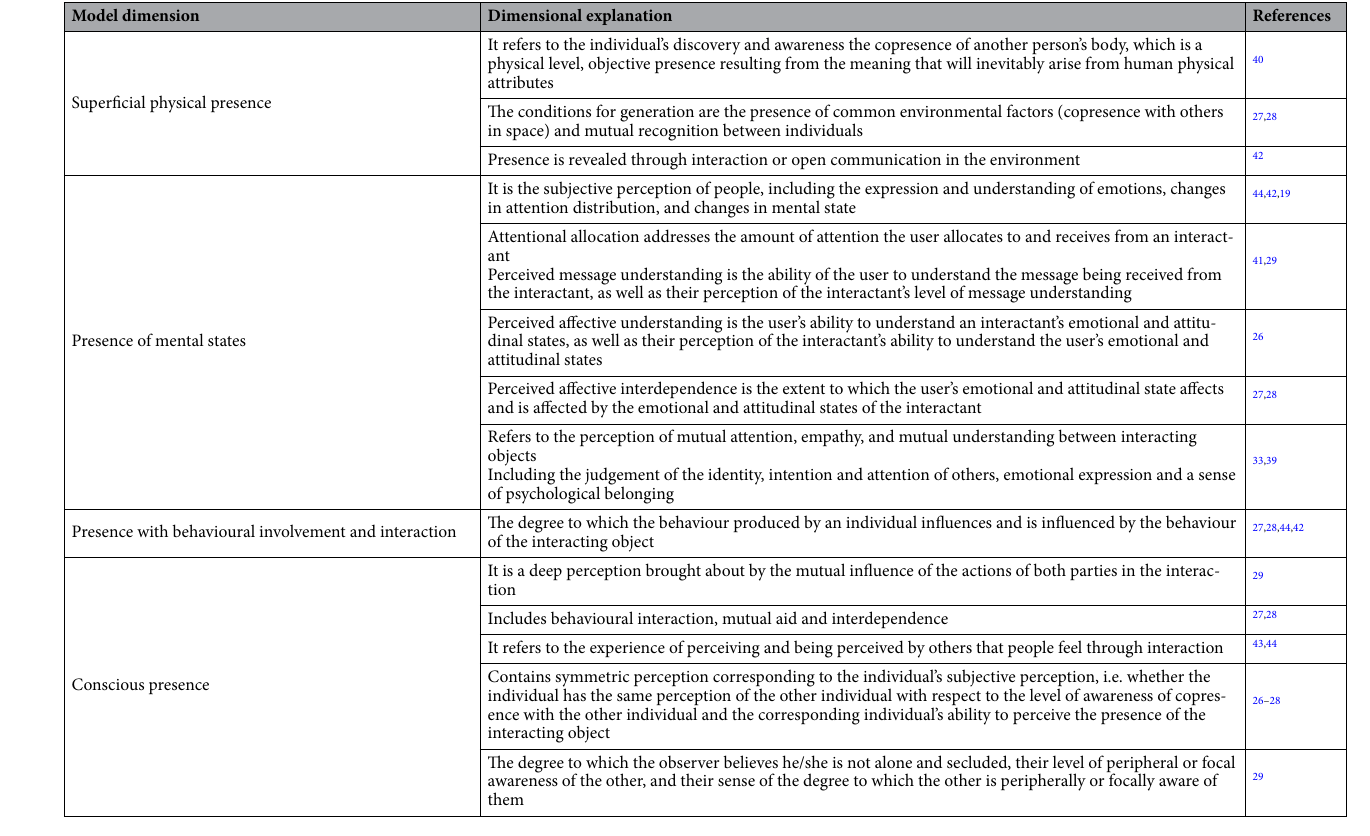
Table 2. Summary of the social presence dimension in previous studies (human–human